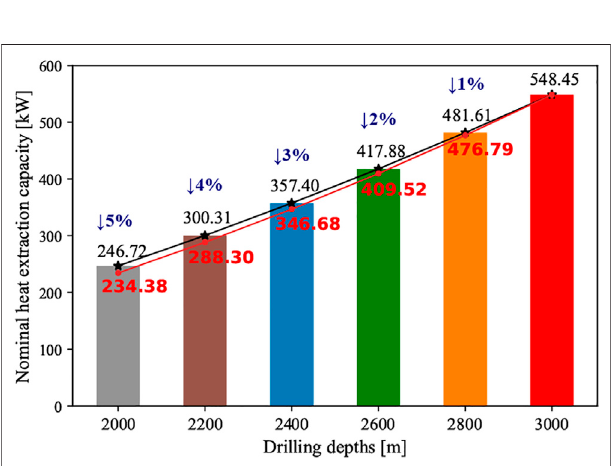
FIGURE 6 | Determination of tentative heat extraction capacity for the DBHE with different drilling depths.